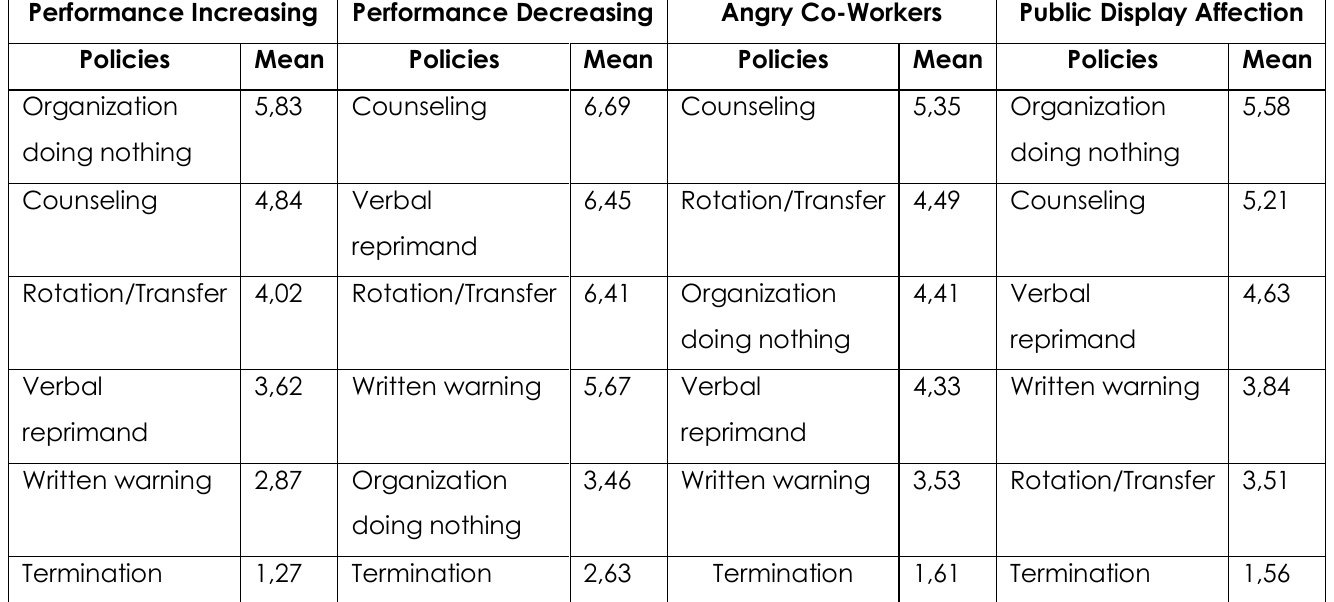
Table 9. Rank of Romance Policies based on Relationship Impact Performance Increasing